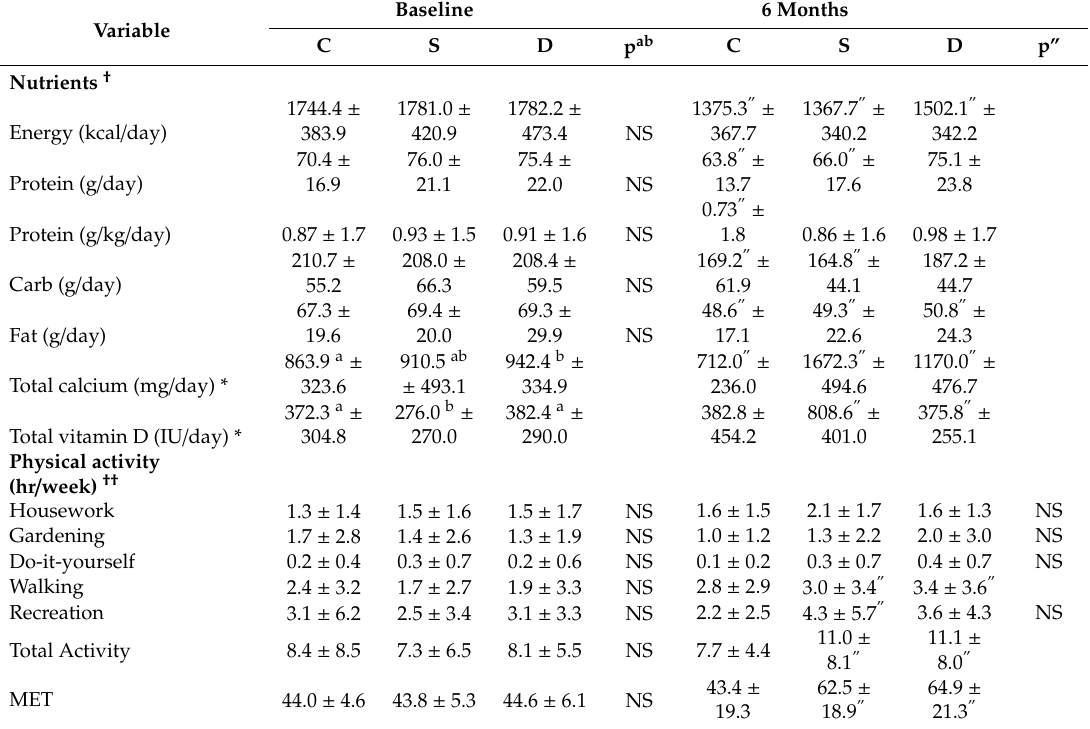
Table 3. Relevant dietary and physical activity variables (mean ± SD) at baseline and 6 months in participants stratified according to the study groups; n = 30, n = 37, n = 30 for control / placebo (C), supplement (S) and dairy (D) group,